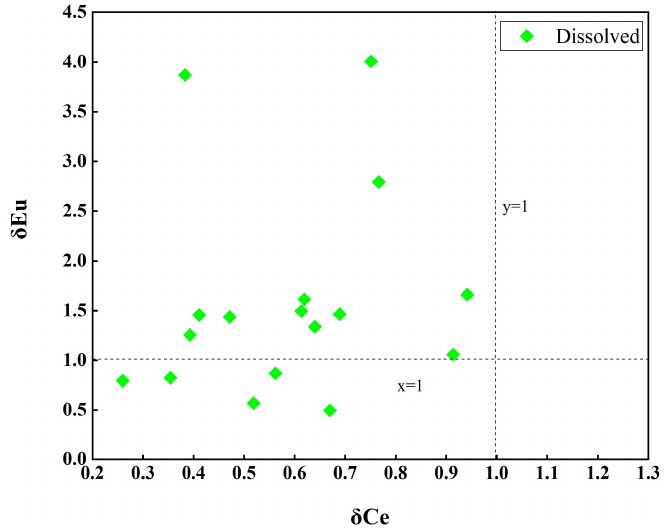
Figure 4. δ Ce ‐δ Eu diagram of REEs in the Yongding River.